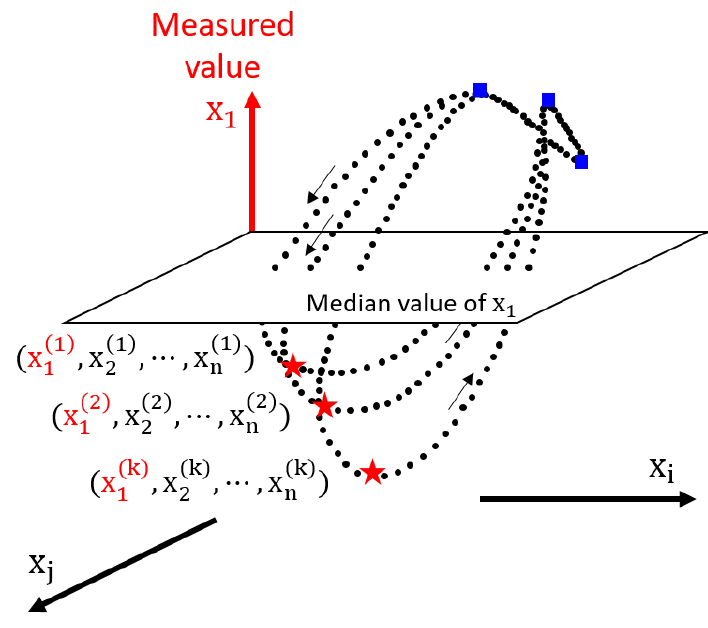
Figure 3. Selecting Poincaré section for time series